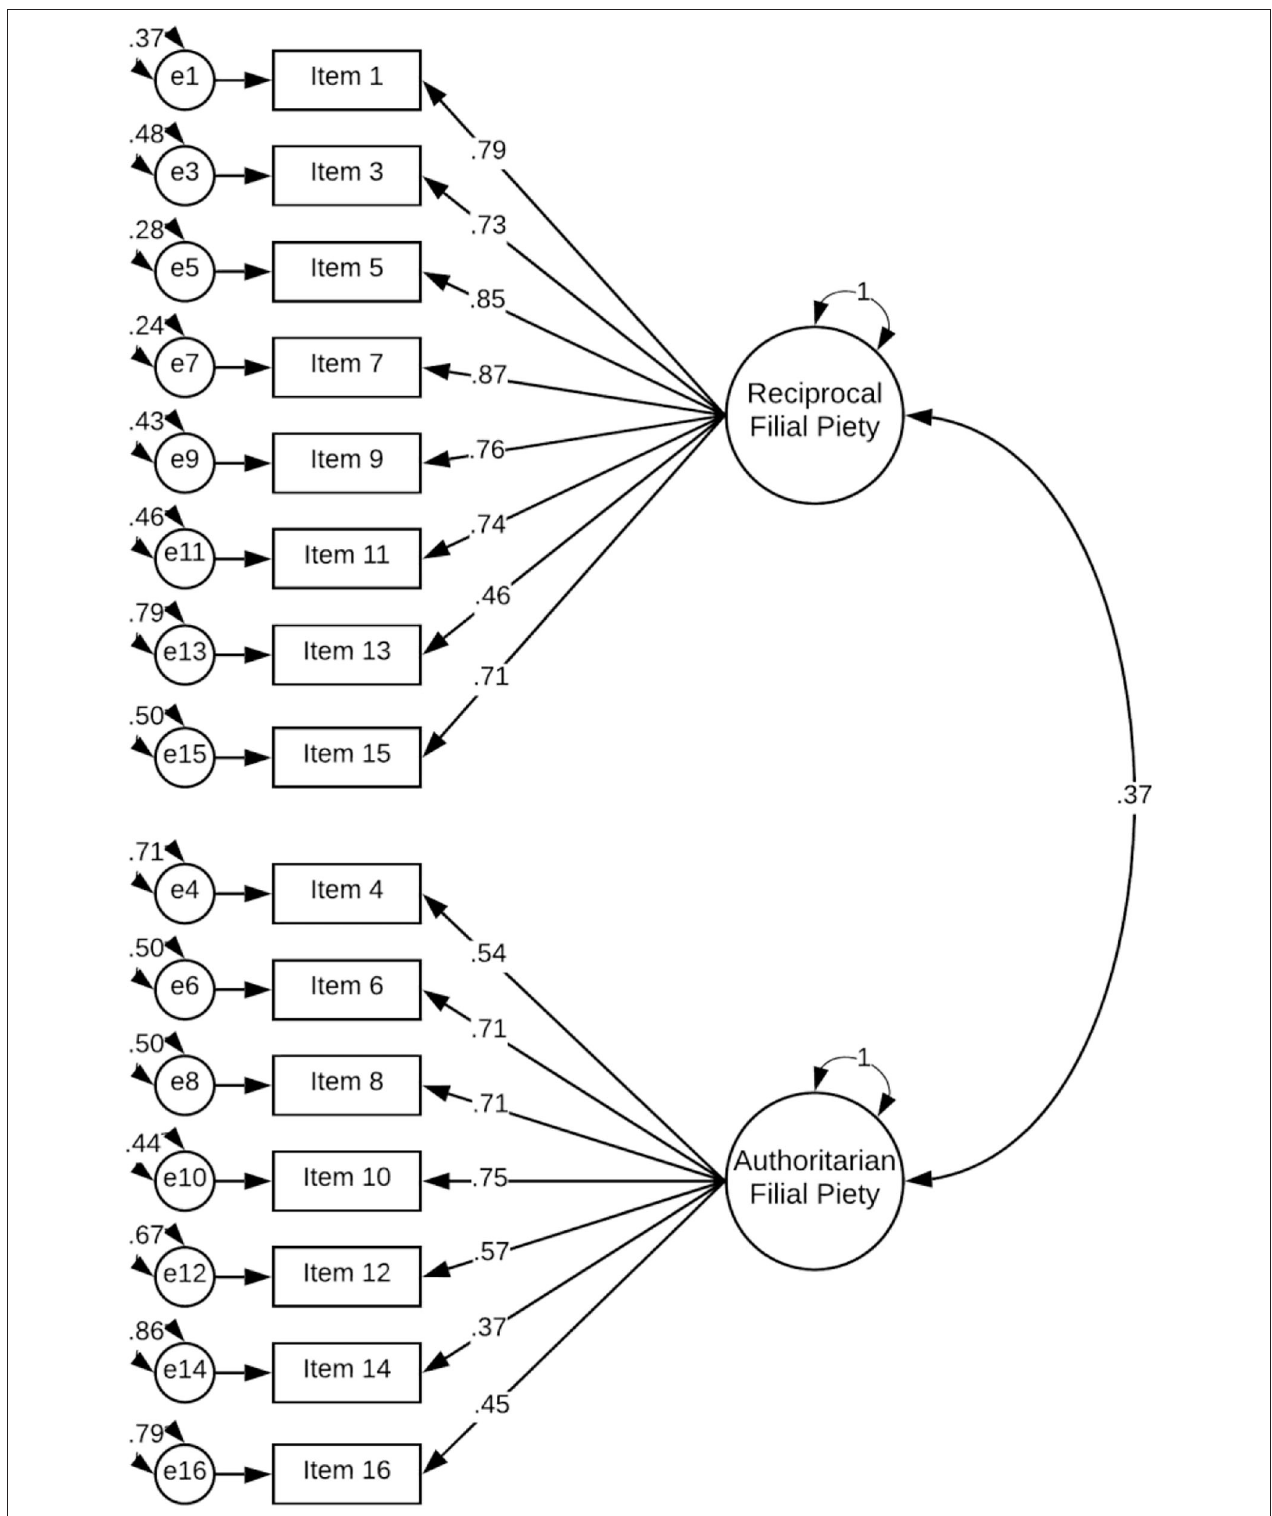
FIGURE 1 | CFA results (standardised loading coefficients) of the DFPS-PL (the total sample).